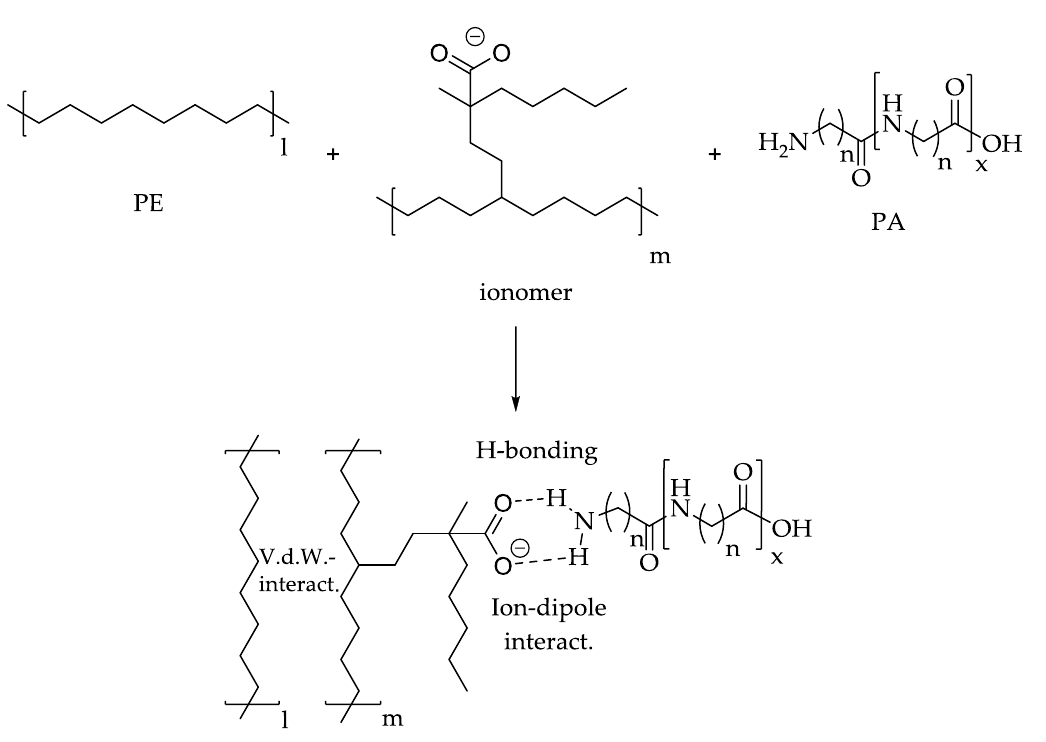
Figure 4. Compatibilization mechanism of PE and PA using an ionomer. Adapted from [88]. Blends compatibilized by the ionomer exhibit a higher degree of crystallinity, which causes even better tensile properties than the blends compatibilized by PE- g -AH.